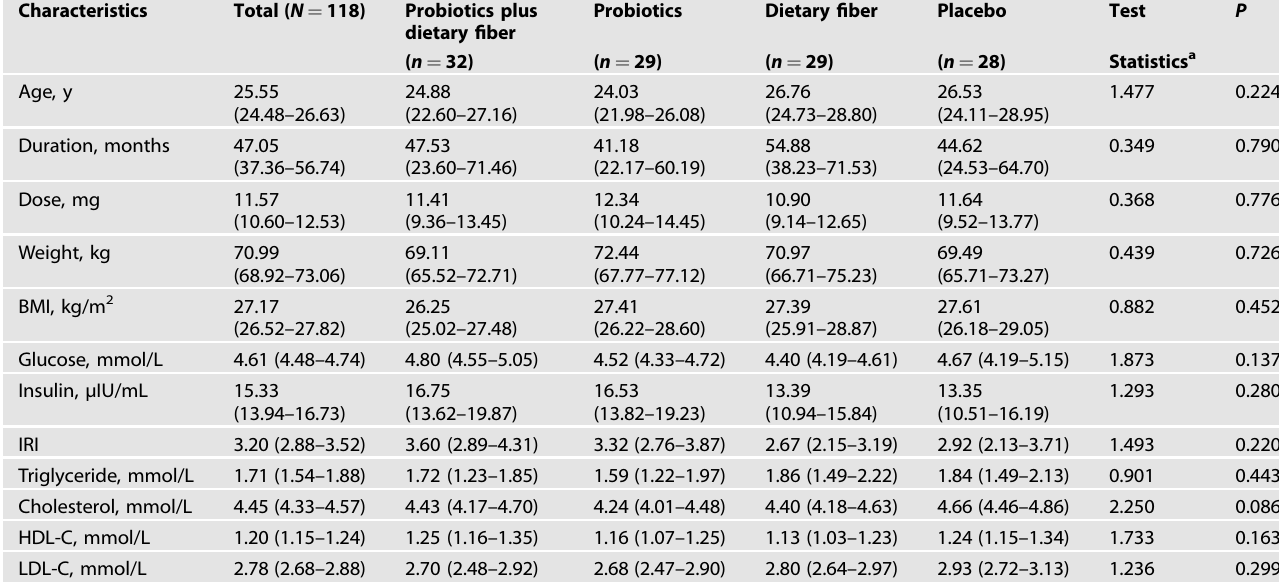
Table 1. Demographic and clinical characteristics of 118 participants across treatment groups at